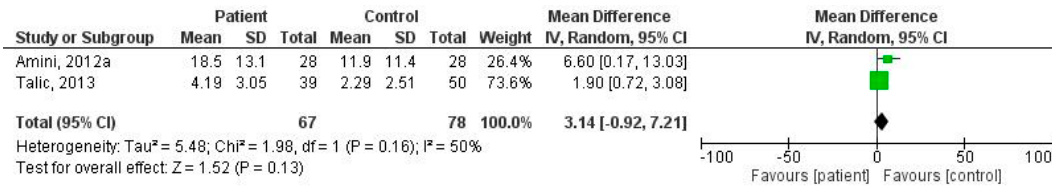
Figure 5. Forest plot of the random effect of salivary nickel levels in patients under fixed orthodontic treatment in case-control studies.